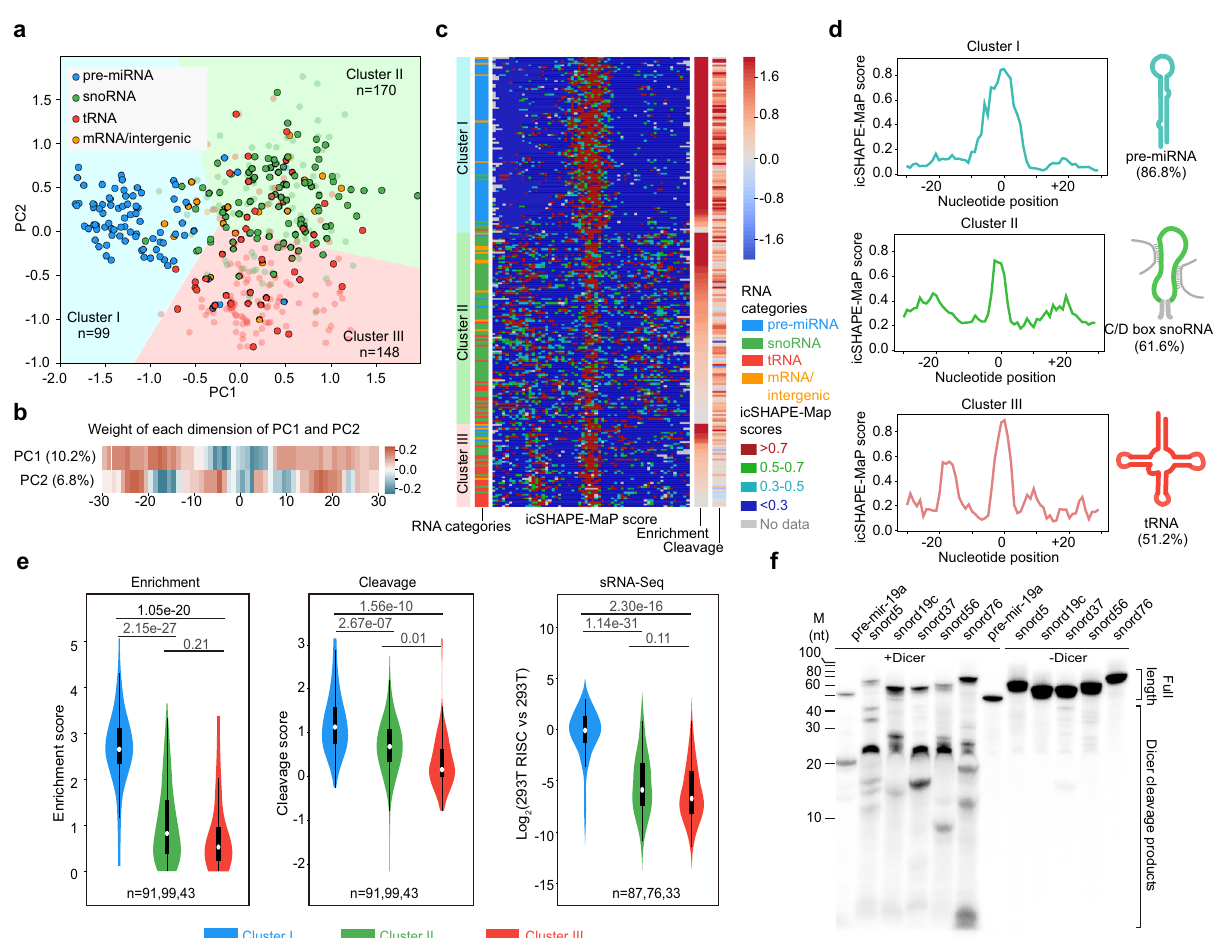
Fig. 3 Clustering analysis reveals distinct structural features for Dicer substrates. a Scatter plot of PC1 (10.2%) and PC2 (6.8%) in the PCA analysis using icSHAPE-MaP scores of 30 nt fl anking each of the center loops. The dot color indicates its RNA category. Transparent dots suggest that they are not enriched by Dicer RIP. K-means clustering divides all RNAs into three clusters with different background colors. b Heatmap of the weights of each position for PC1 and PC2 in the PCA analysis. c Heatmap of icSHAPE-MaP scores of Dicer substrates. For each column, the cluster ID, RNA category, icSHAPE-MaP scores, enrichment score, and Dicer cleavage score are indicated. d icSHAPE-MaP score pro fi les (left) and cartoon diagrams (right) for representative RNAs of each cluster are shown. e Violin plots of enrichment scores (left, n = 91, 99, or 43, respectively), Dicer cleavage scores (middle, n = 91, 99, or 43, respectively), and sRNA expression level enriched by AGO2 IP in HEK293T cells (right, n = 87, 76, or 33, respectively) for RNAs in the three clusters of Dicer substrates. p values were determined with a two-sided paired Student ’ s t test. Violin plots show the median (white circle), 25/75 percentiles, and the smallest/largest values within 1.5 times the interquartile range above/below quartiles. f In vitro dicing assay validated selected snoRNAs as Dicer cleavage substrates. The experiment was repeated two times with similar results. Source data are provided as a Source Data fi